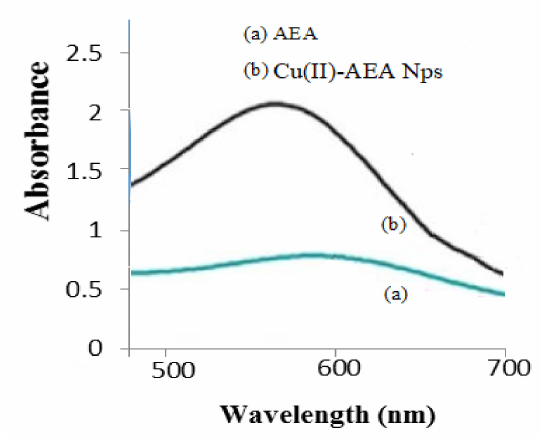
Figure 2. UV–vis spectra of Cu(II)-AEA NPs.